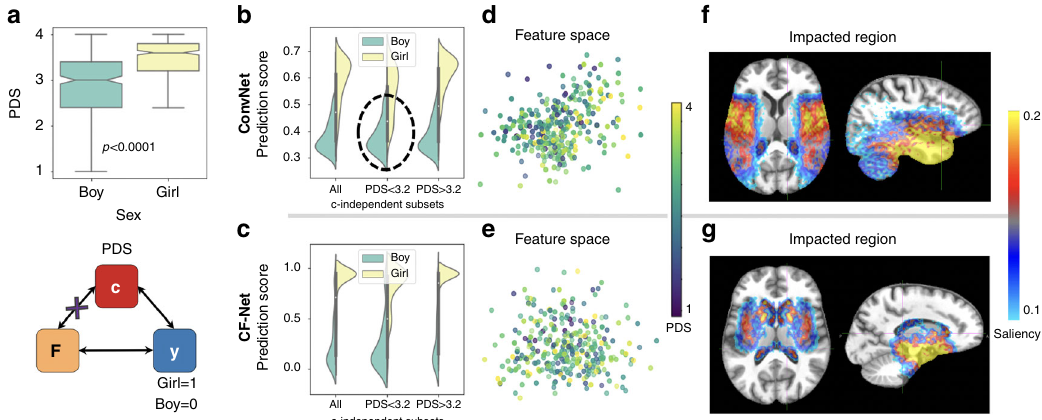
Fig. 4 Sex prediction from adolescent brain MRIs. a Signi fi cantly different pubertal development scores (PDS) between n = 334 boys and n = 340 girls ( p < 0.0001 two-tailed two-sample t -test). Boxplots are characterized by minimum, fi rst quartile, median, third quartile, and maximum. b , c Sex-prediction scores measured on all subjects and the c -independent subset containing n = 200 boys and n = 200 girls. d , e t-SNE visualization of the feature space learned by the deep-learning models. f , g Saliency maps of sex differences.